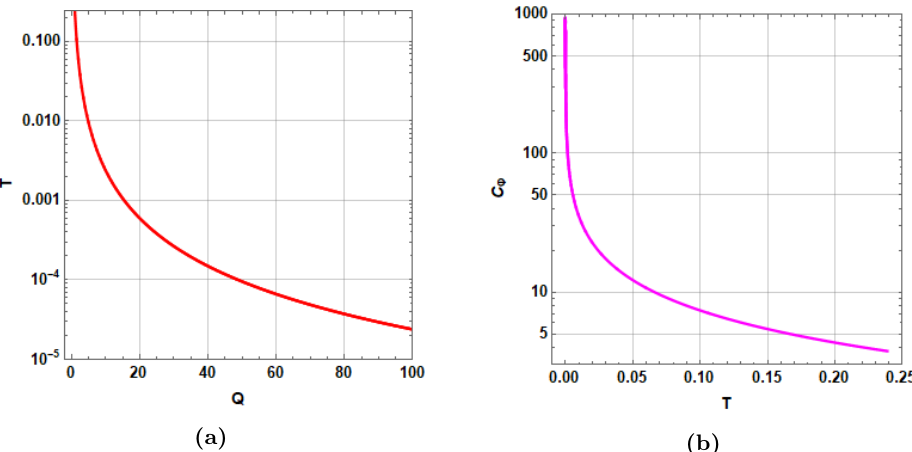
Figure 28. (a) Temperature as a function of black hole charge during absorption of 10 5 particles with a fixed electric charge dQ = 0 . 001 . (b) Heat capacity at the constant electric potential in terms of black hole temperature during absorption of 10 5 particles with a fixed electric charge dQ = 0 . 001